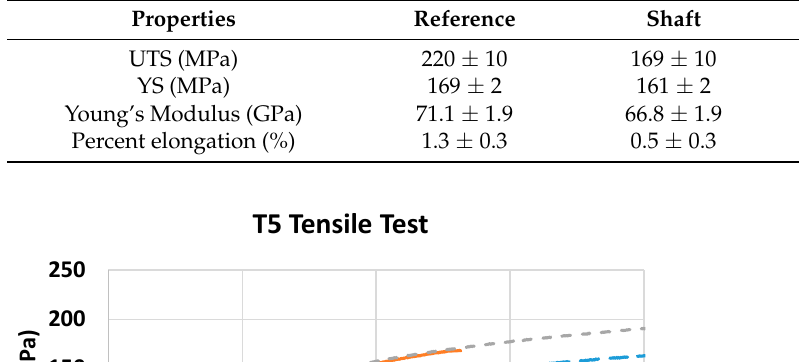
Table 7. Tensile test results for the T5 heat-treated gearcase.